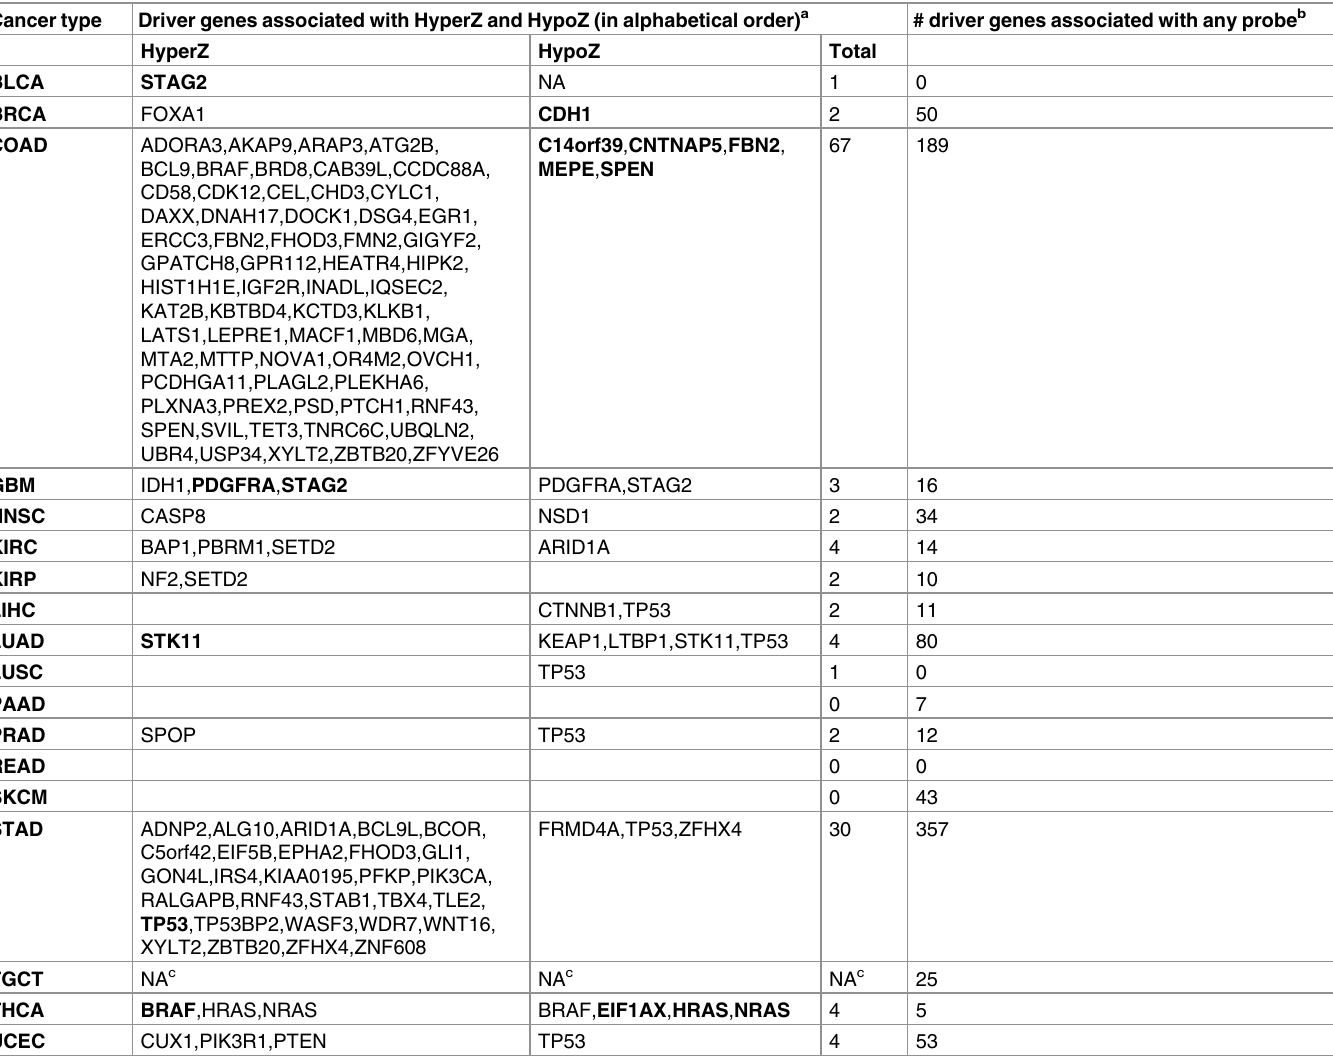
Table 2. Associations between mutated driver genes and HyperZ and HypoZ indices or site–specificmethylation alterations. Cancer type Driver genes associated with HyperZ and HypoZ (in alphabetical order)